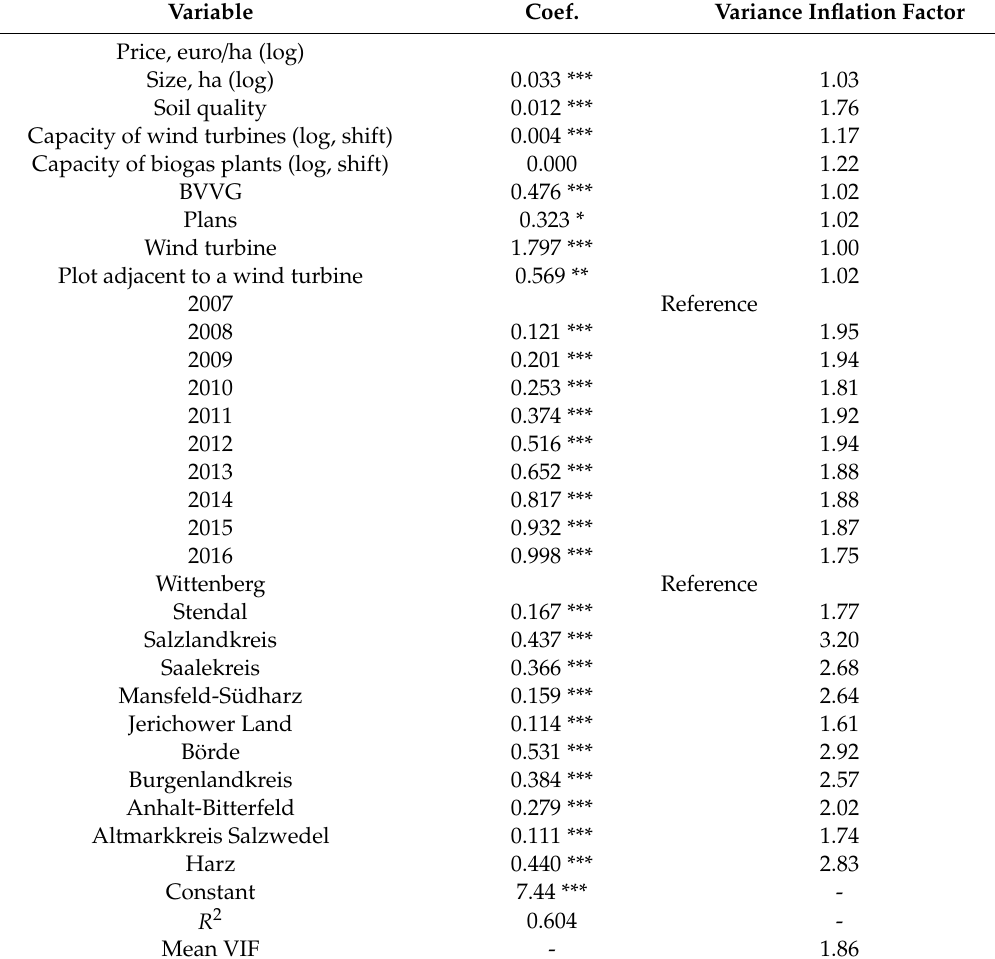
Table 4. Regression results for transaction-based model ( N = 32,599). Variable